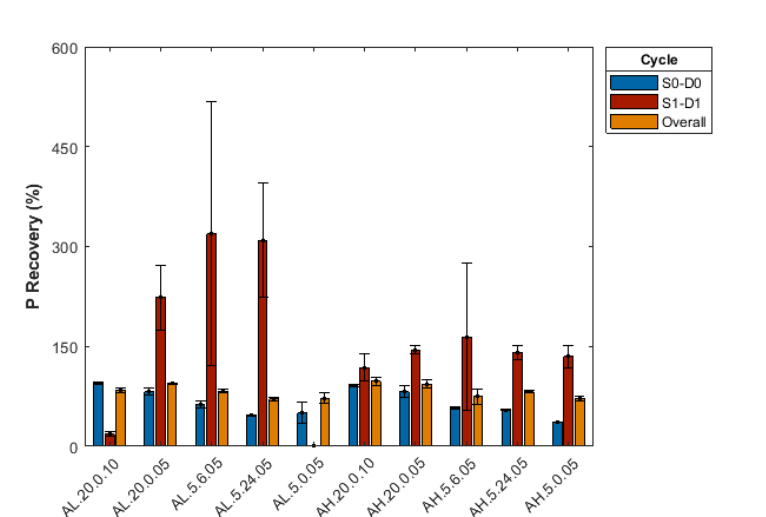
Figure 8. Phosphorus (P) recovery across all evaluated cycles and treatments for Alcan. The treatments identified on the x-axis follow the notation: AX.PV.RC.RT, with X being the level of P concentration (L for low or 0.5 mg L − 1 and H for high or 50 mg L − 1 ), PV: pore volume (5 or 20), RC: number of recirculations (0,6 or 24) and RT: residence time used in the desorption phase. Phosphorus recovery in the S1-D1 cycle was omitted for the treatment AL.5.0.05, which showed an average of 3233% with standard deviation ( S x ) of 2997.